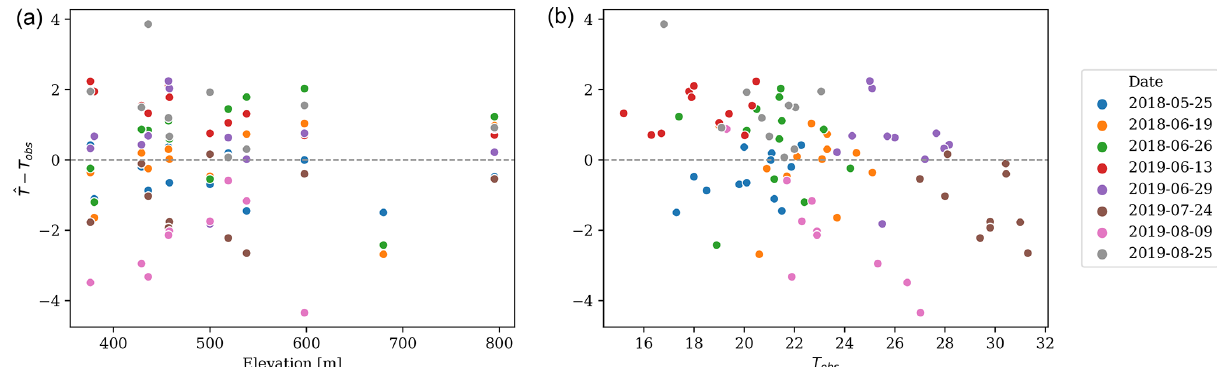
Figure 2. Scatterplot of the spatial regression residuals ( y axis) against the elevation of the monitoring station ( x axis of panel a ) and the observed T air ( x axis of panel b ), colored by the sample date. See Appendix B.